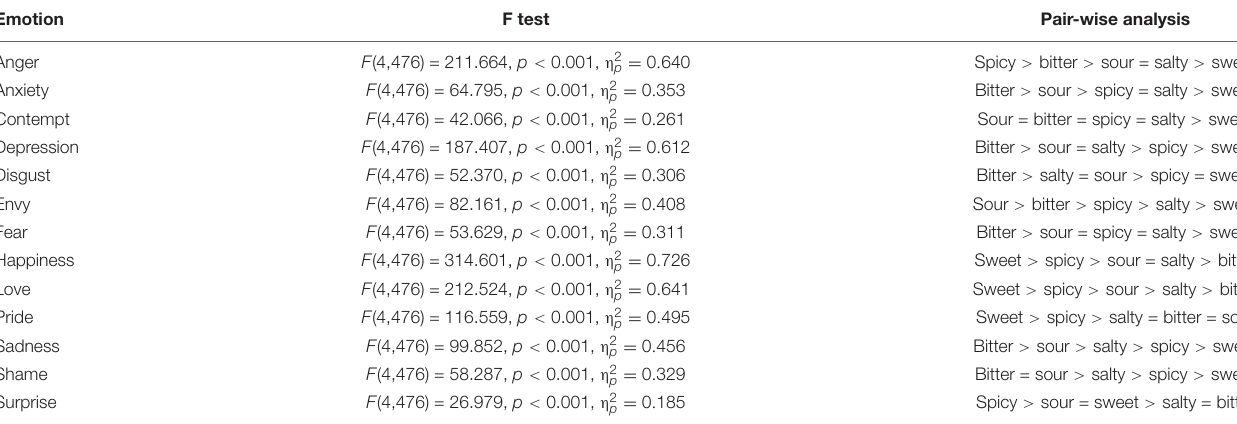
TABLE 3C | Results of repeated-measures ANOVA for each of the 13 emotion. Emotion F test Pair-wise analysis